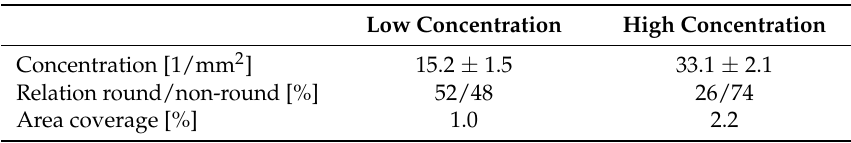
Table 1. Cell measurement results of neuroblastoma cell